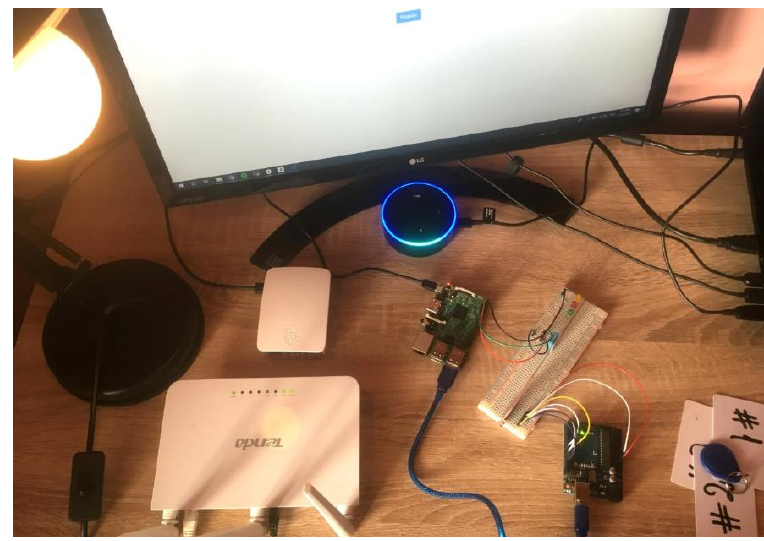
Figure 8. Experimental setup. Table 1. Experimental test